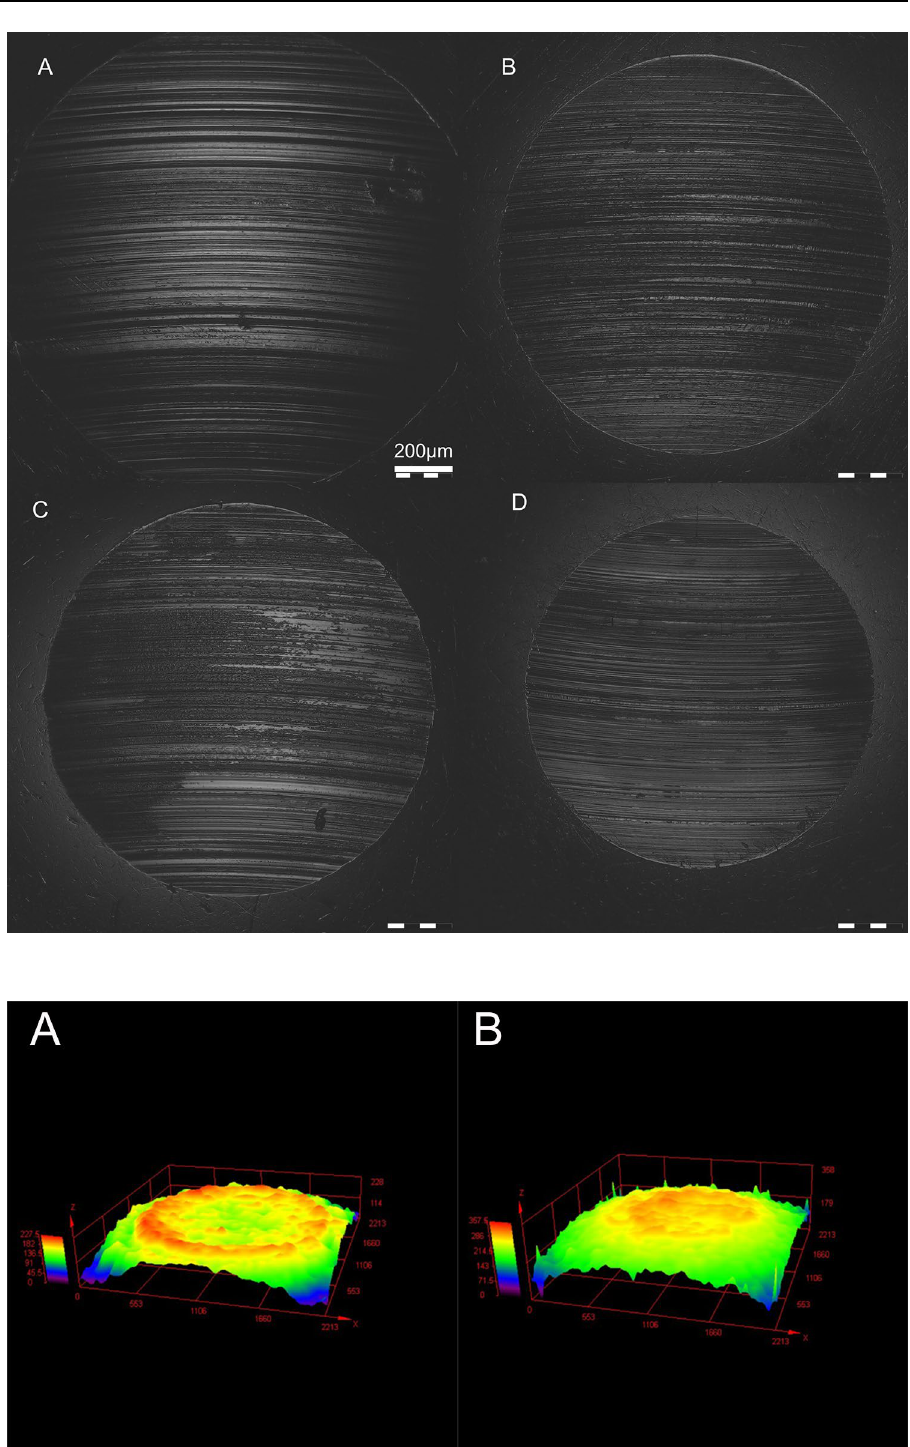
Fig.10 Worn surface of steel ball after friction test under